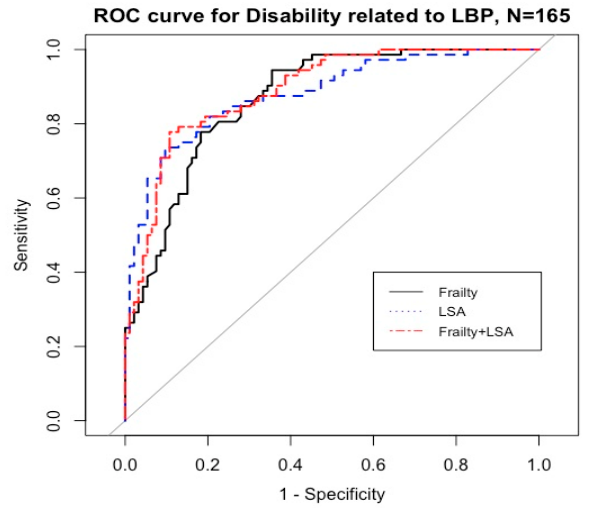
Figure 1. Predictive power of frailty and life-space mobility on the disability related to LBP. Abbreviations : ROC = receiver operating characteristics .